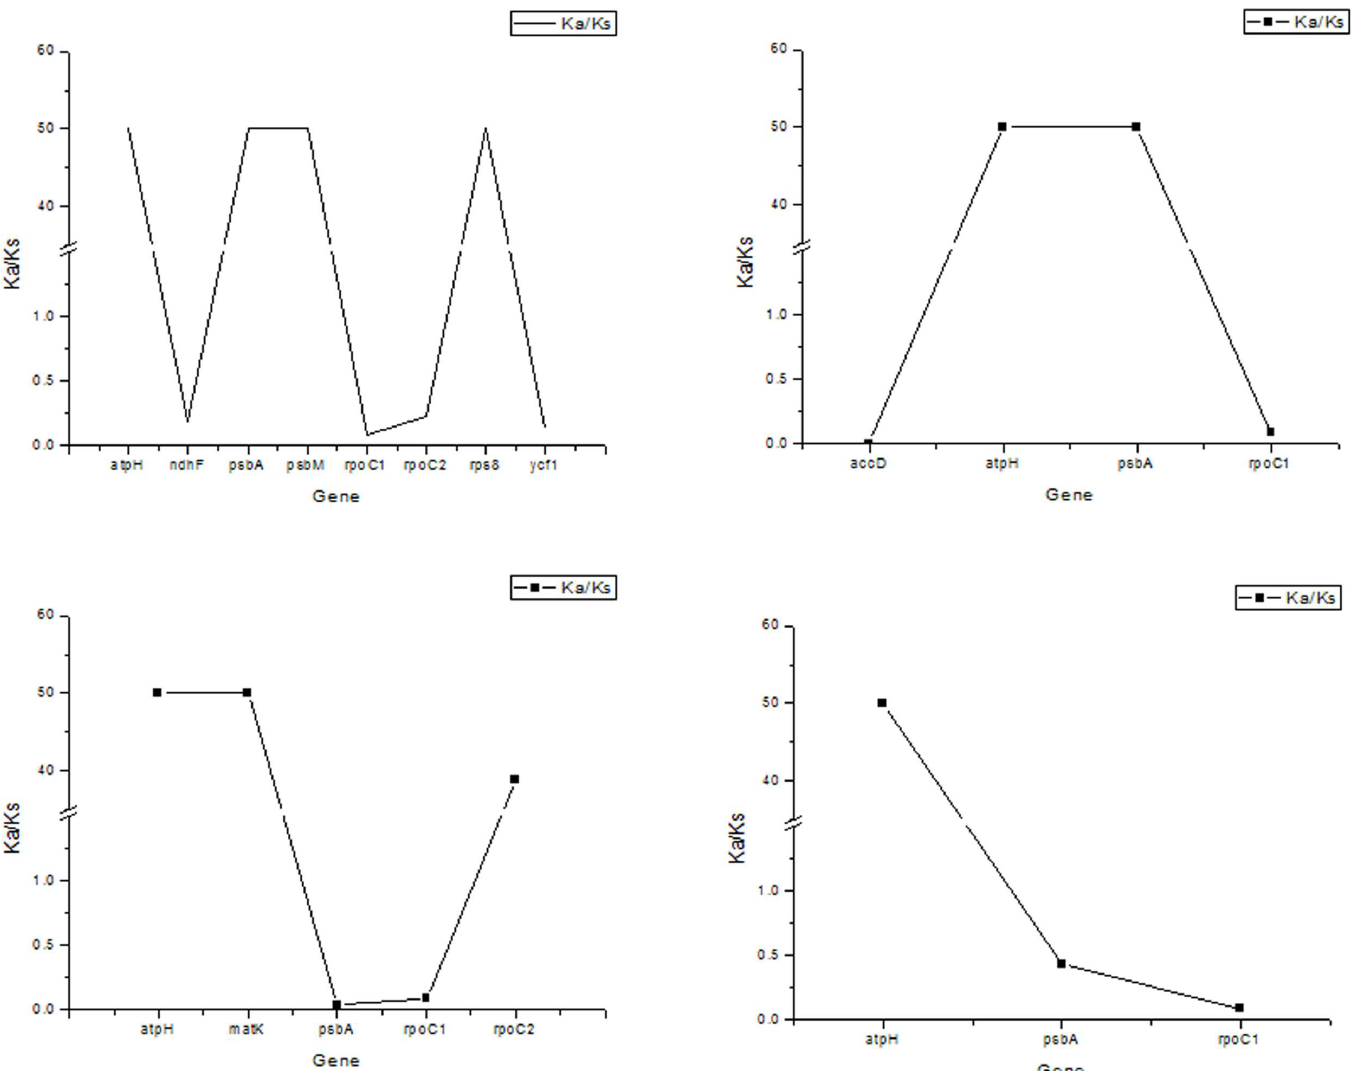
Fig 7. Ka/Ks values of five Ulmus species. A–D represent the Ka/Ks values of U . davidiana var. japonica , U . macrocarpa , U . davidiana ,and U . laciniata with respect to U . pumila